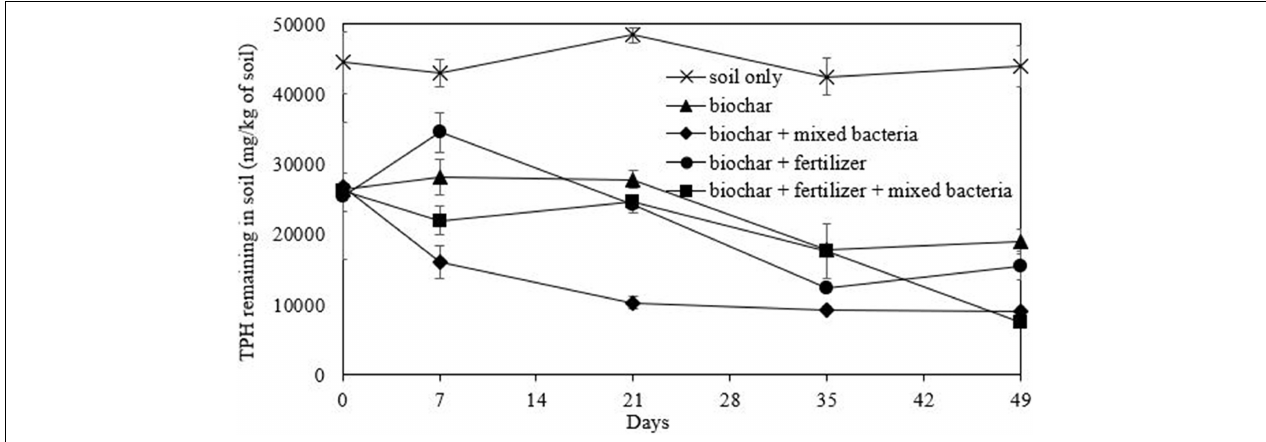
FIGURE 6 | Efficiency of bioremediation approaches comprising of mixed bacterial inoculum, biochar and fertilizer on the removal of petroleum hydrocarbons (TPHs) from drill cuttings after washing in a scale-up